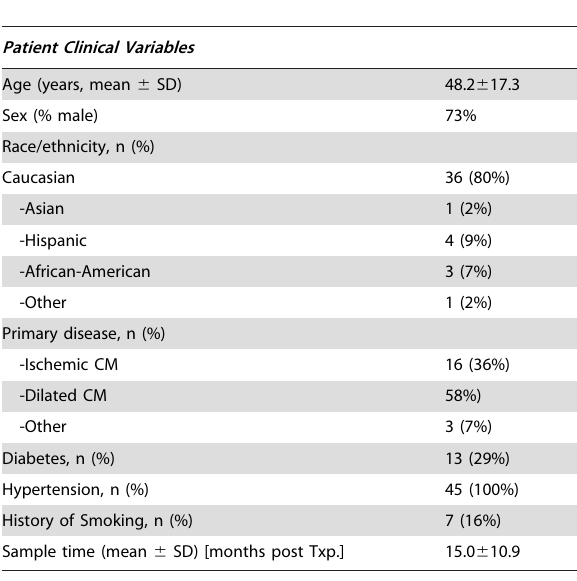
Table 2. Clinical profile of 45 study